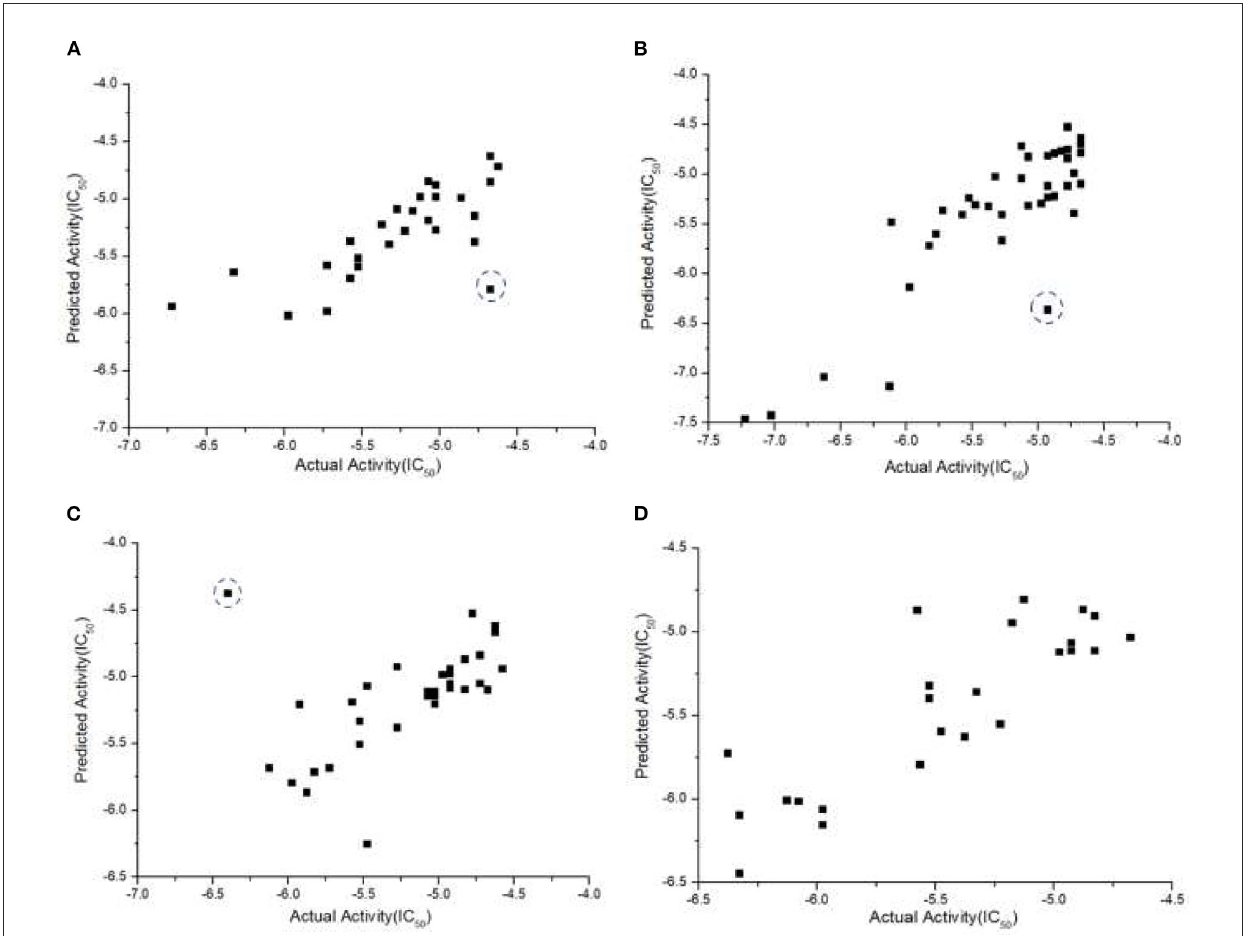
FIGURE6 Predicted vs. actual activities (IC 50 ) of drugs in TNBC, including (A) HCC-1937, (B) MDA-MB-231, (C) MDA-MB-453, and (D) MDA-MB-436. The red-circled compound 3-Methyladenine as an outlier was not accurately predicted. Further analysis shows that no compound in the training set is similar enough to 3-Methyladenine while there are always similar compounds to the accurately predicted ones (blue-circled Afatinib and UNC-0638).